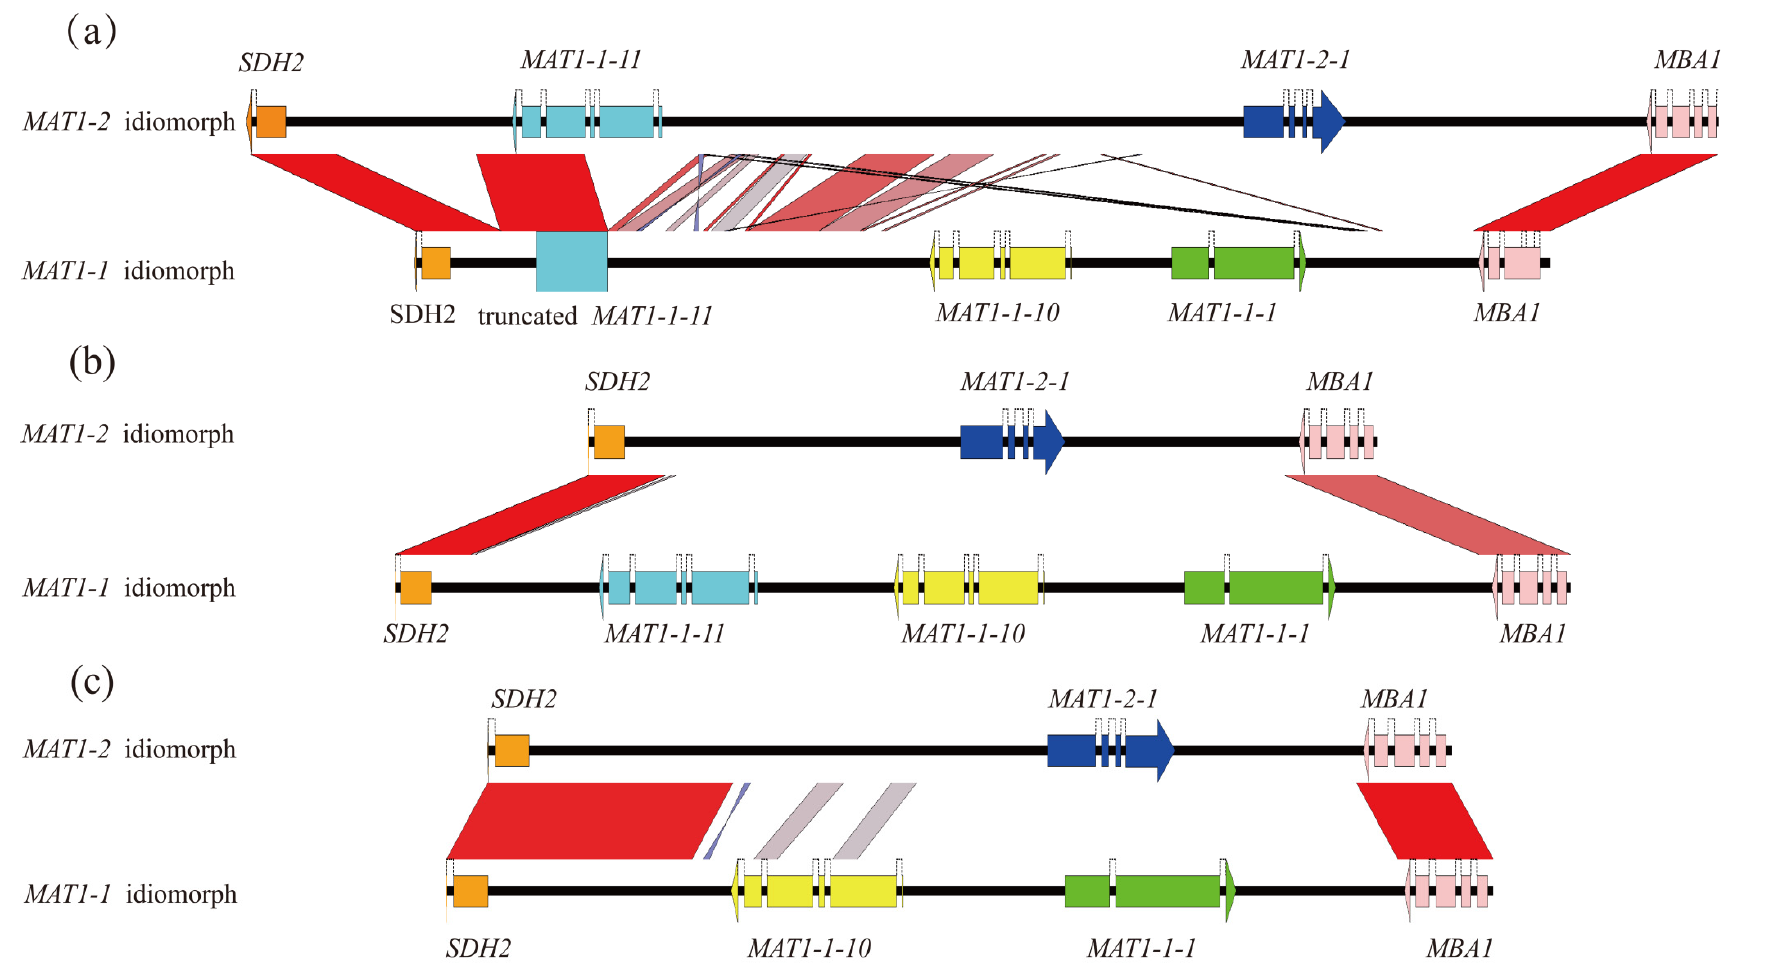
Figure 3. Comparison of the opposite-mating idiomorphs from the same species. Comparison of the opposite-mating idiomorphs of ( a ) M. pulchella , ( b ) M. eximia , ( c ) Mes-19 . Black horizontal lines represent genomic sequences, and color-coded arrows represent coding sequences. Red or blue boxes between genomic sequences indicate pairwise similarity based on BLASTN. Red boxes indicate that both regions are in the same orientation, and blue boxes indicate that the regions are oriented in opposite directions.